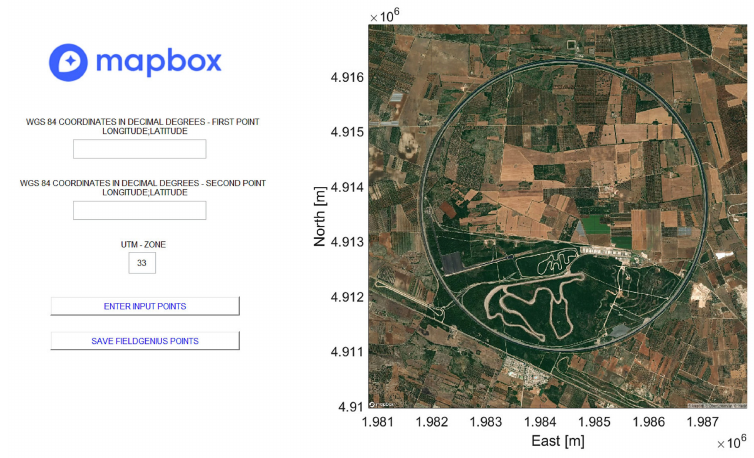
Figure 10. The user interface of the developed Matlab Mapbox